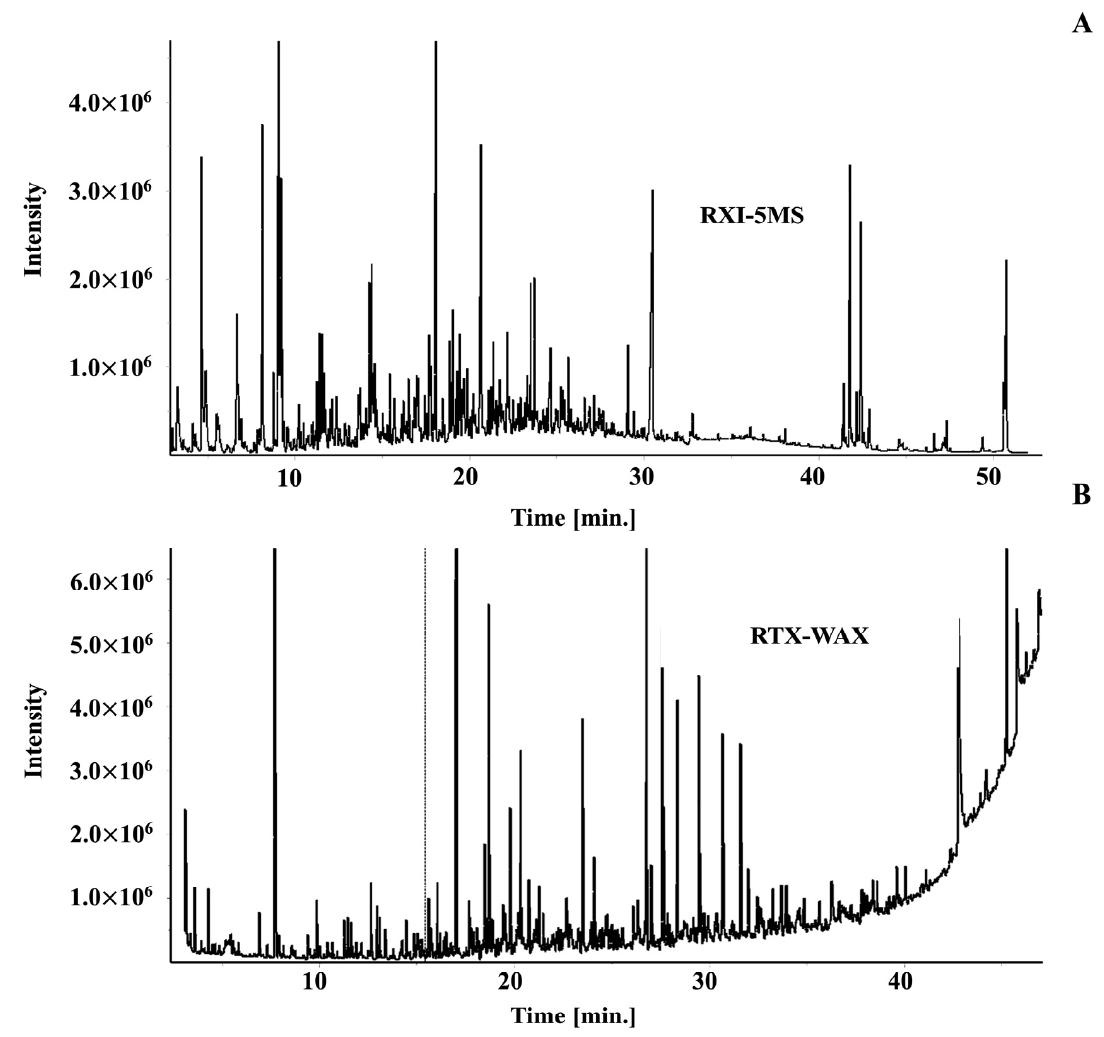
Figure 1. GC/MS chromatogram of roasted coffee on ( A ) non-polar (RXI-5MS) and ( B ) polar (RTX- WAX) phases.